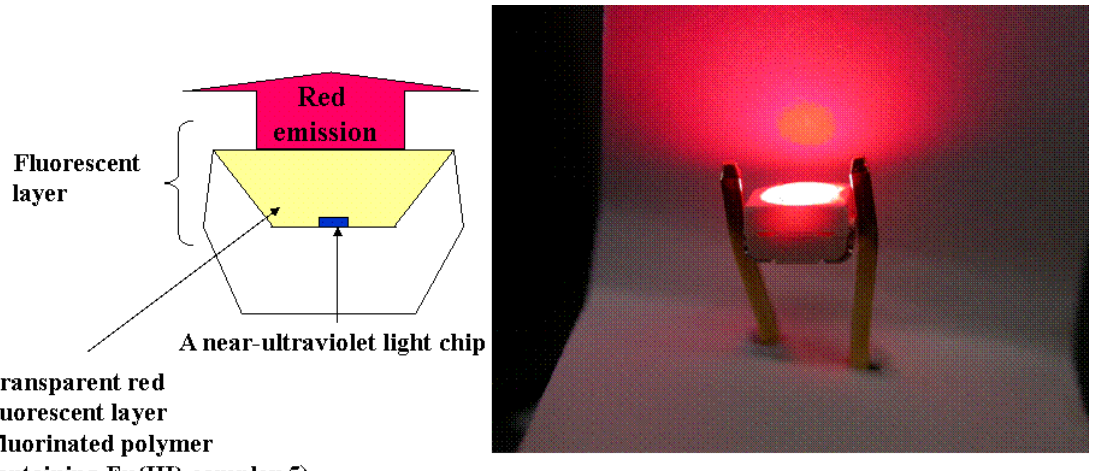
Figure 20. LED devices containing novel Eu(III) complexes in the fluorescent layer.